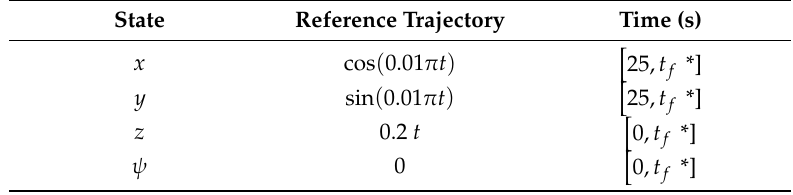
Table 10. Leader orientation-based formation tracking a helical trajectory input signals.